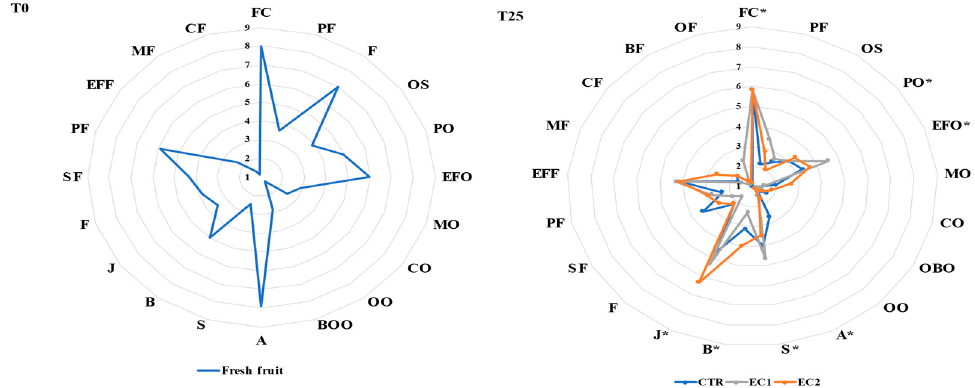
Figure 4. Sensory analysis at T0 and T25 of C. papaya descriptor legend: flesh color (FC*), presence of filaments (PF), odor of sea (OS), peach odor (PO*), exotic fruit odor (EFO*), medicinal odor (MO), cheese odor (CO), odor of burnt oil (OBO), odor of oregano (OO), acid (A*), sweet (S*), bitter (B*), juiciness (J), flouriness (F), sea flavor (SF), peach flavor (PF), exotic fruit flavor (EFF), medicinal flavor (MF), cheese flavor (CF), burnt oil flavor (BF), oregano flavor (OF). The descriptors marked with an * were those that reported a statistically significant value of p ≤ 0.05.